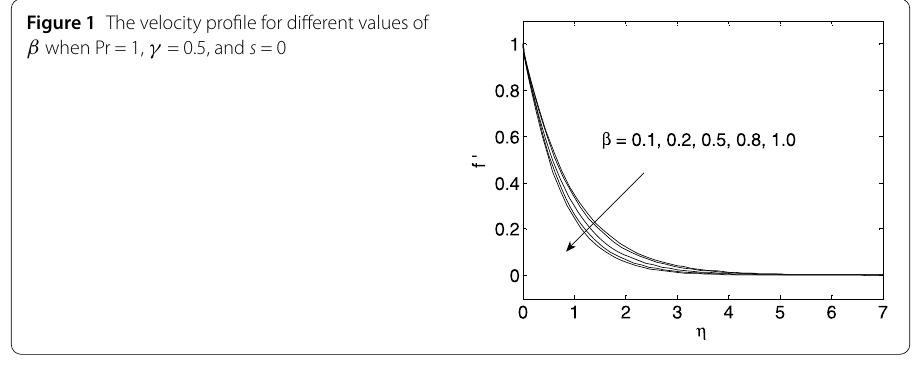
Figure 2 The temperature profile for different values of β when Pr = 1, γ = 0.5, and s =